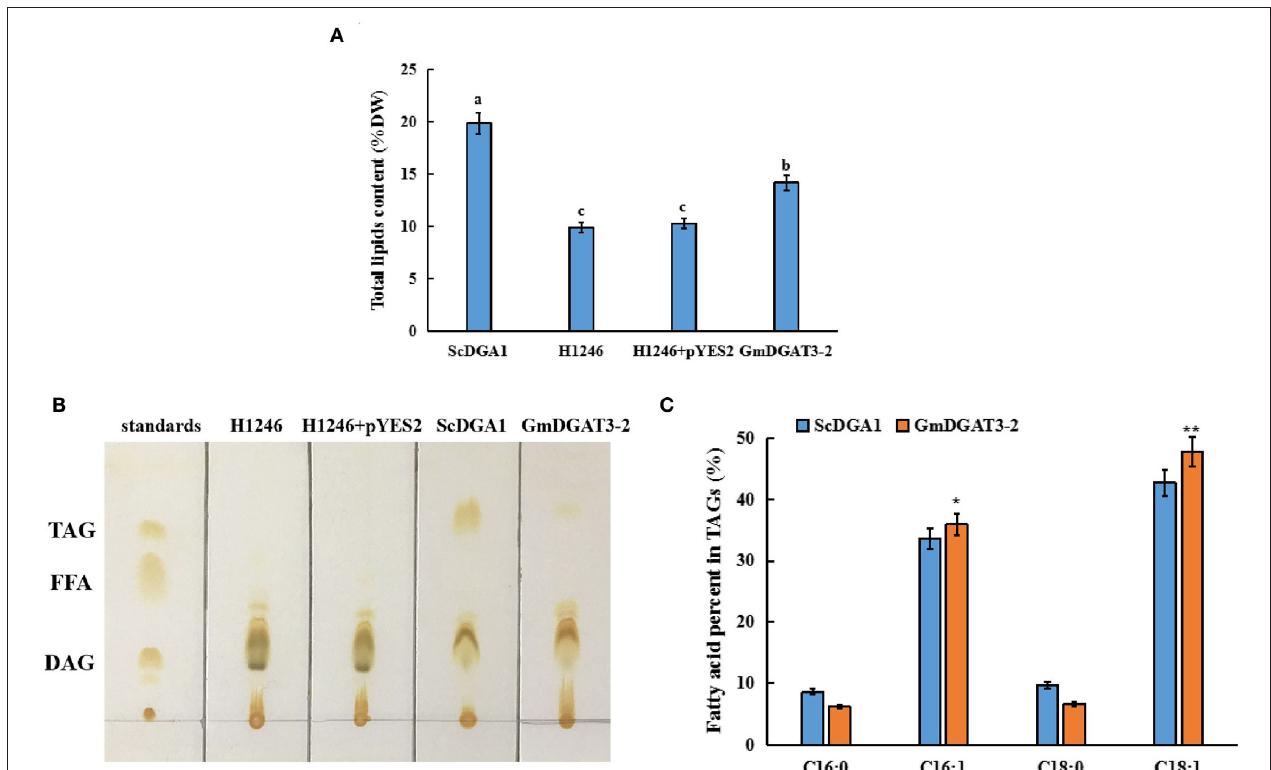
FIGURE 5 | Lipid analysis in yeast H1246 transformed with GmDGAT3-2 gene. (A) Total lipid content in yeast H1246 expressing GmDGAT3-2 . The bars were SD s of three biological repeats. Different lowercase letters indicate significant differences at the P < 0.05 level. (B) Thin-layer chromatography (TLC) analysis of neutral lipids in yeast H1246 expressing GmDGAT3-2 gene. Lipid spots were detected under UV after staining with iodine vapor. Lane 1, standards of acyl-lipid classes: TAG (triacylglycerol), FFA (free fatty acids), and DAG (diacylglycerols); Lane 2, H1246, the yeast strain H1246; Lane 3, H1246 + pYES2, H1246 expressed empty vector (pYES2); Lane 4, ScDGA1, H1246 expressed yeast DGAT2; Lane 5, GmDGAT3-2, H1246 expressed GmDGAT3-2. (C) Fatty acid composition in TAG of yeast H1246 expressing GmDGAT3-2 gene. ScDGA1, H1246 expressing yeast DGAT2 . GmDGAT3-2, H1246 expressing soybean GmDGAT3-2 gene. The bars were SD s of three biological repeats. Asterisks indicate significant difference between GmDGAT3-2 and the ScDGA1 according to t -test at ** P < 0.01, and * P < 0.05, respectively.